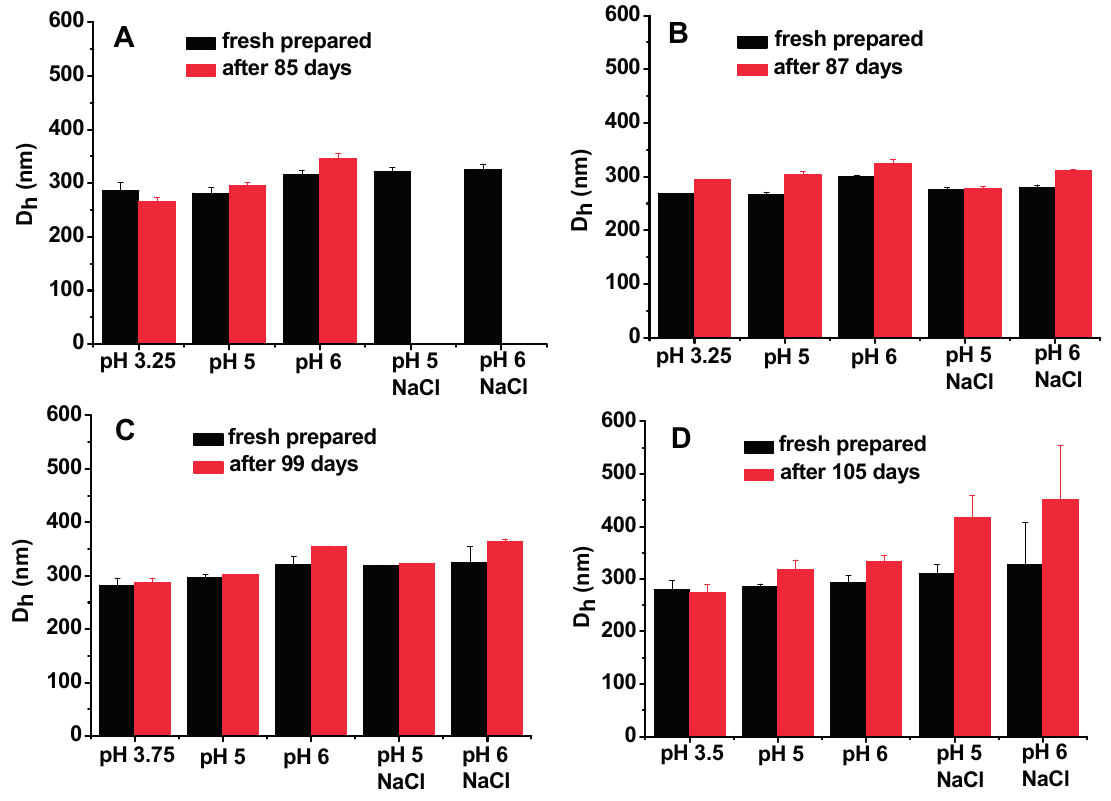
Figure 6. Droplet size changes of ( A ) Complex1, ( B ) Complex2, ( C ) Complex3, and ( D ) Complex4 emulsions before and after storage at 4 °C in different pH media with or without 0.2 M